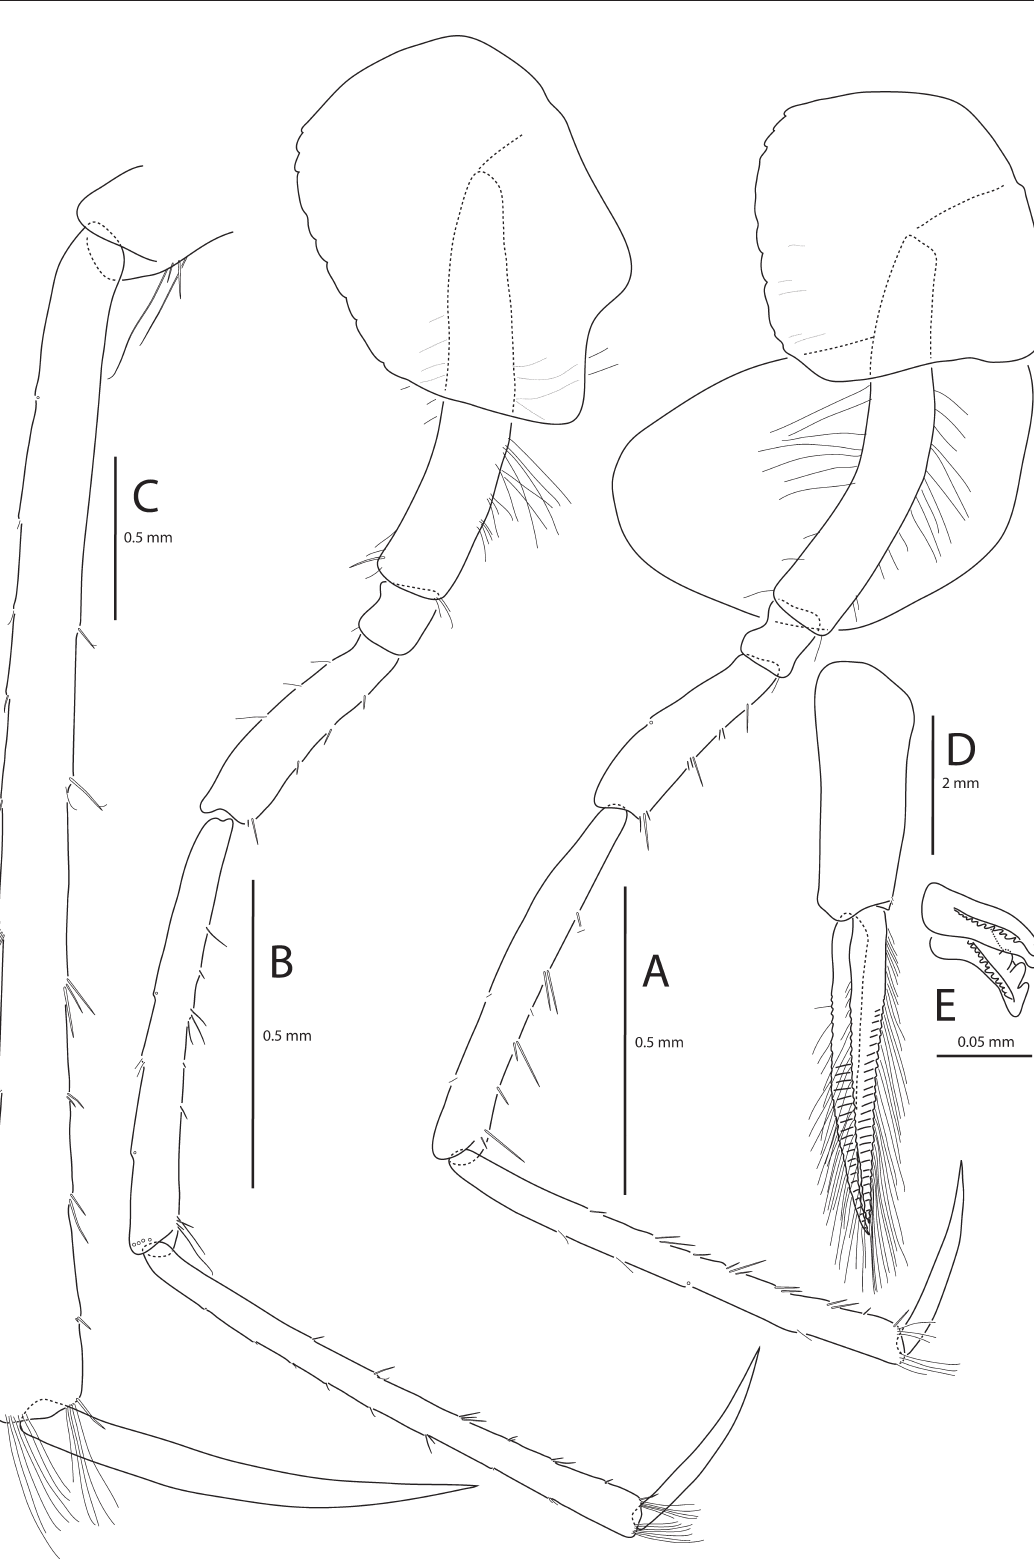
Fig. 5. Halirages cainae sp. nov., holotype ♂, 40 mm, Norwegian Sea, MAREANO 2009-111, R-station 487, sample 157. A . left P3. B . left P4. C . propodus and dactylus of left P4. D . left pleopod 1. E . coupling hooks of left pleopod